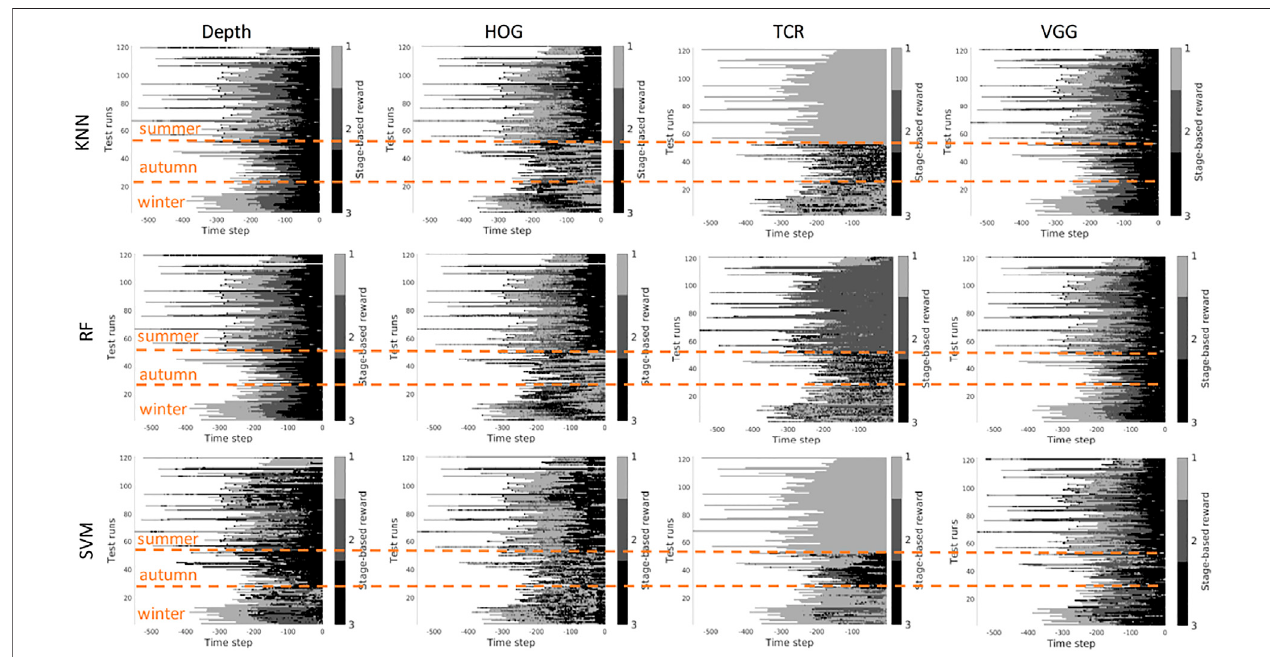
FIGURE12| Stage-basedreward plotted forallseasons. Scenario 2:trained onthemixed setofdata, 3stages. Thestagesproceed asfollows: S 1 − > S 2 − > S 3. x -axis stands for the time step in reversed order to match the samples of varying length. Color bar encodes the stages: S 1 - light gray, S 2 - gray, S 3 - black.